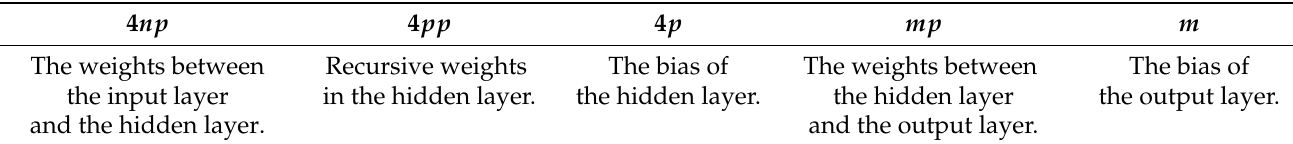
Figure 6. The LSTM power consumption forecasting framework. Table 1 explains each parameter used in the previous equation. Table 1. Trainable Weights in the LSTM